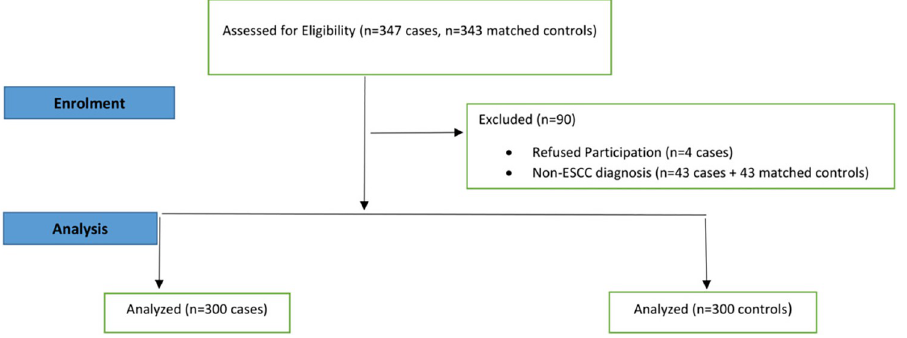
Fig 1. Participant enrolment flow into the ESCC case-control